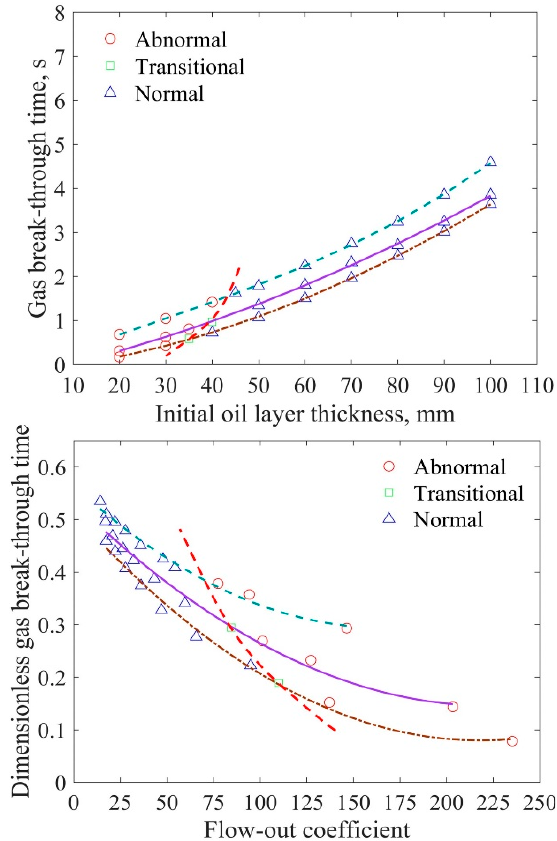
Figure 12. Effect of initial l–l interface level on the drainage end state. Pressure difference: 0.3 bar, oil viscosity: 0.131 Pa · s, initial l–l interface levels: 5 mm (dash-dotted line), 10 mm (solid line), 20 mm (dashed line). Red dashed line shows the states corresponding to transitional drainage.